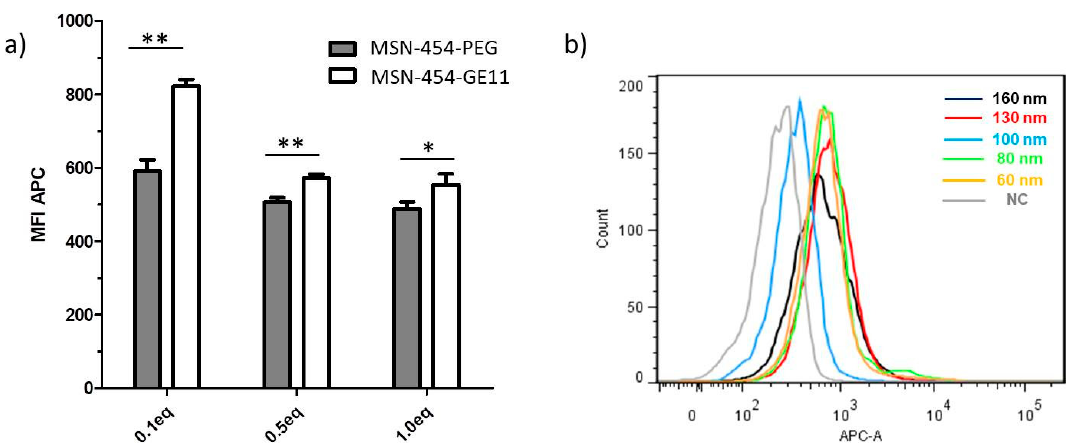
Figure 4. Cellular internalization determined by flow cytometry. Cells were incubated for 45 min, washed and analyzed. ( a ) MSN160 nm-454-PEG was used for passive and MSN160 nm-454-GE11 for receptor-mediated uptake. 454 was functionalized with different equivalents of Mal-PEG (454-PEG) and Mal-PEG-GE11 reagent (454-GE11), respectively, in the range from 0.1 to 1 eq. The mean fluorescence intensity of the Atto-633 signal (MFI APC) represents the amount of internalized nanoparticles. A high MFI corresponds to a large cell uptake of MSN. For statistical analysis, a two-tailed t-test was performed ( n = 3, mean ± SD, * p < 0.05, ** p < 0.01) ( b ) Histograms of cellular internalization of Atto-633 labeled MSN-454-GE11 after 45 min incubation with particle sizes in the range of 160 nm to 60 nm and negative control (NC). The Atto-633 intensity (APC-A channel) is plotted against the number of events detected (‘count’). ‘Count’ represents cumulative counts of cells with indicated Atto-633 fluorescence after appropriate gating by forward / sideward scatter and pulse width. For statistical analysis, see Figure S7.